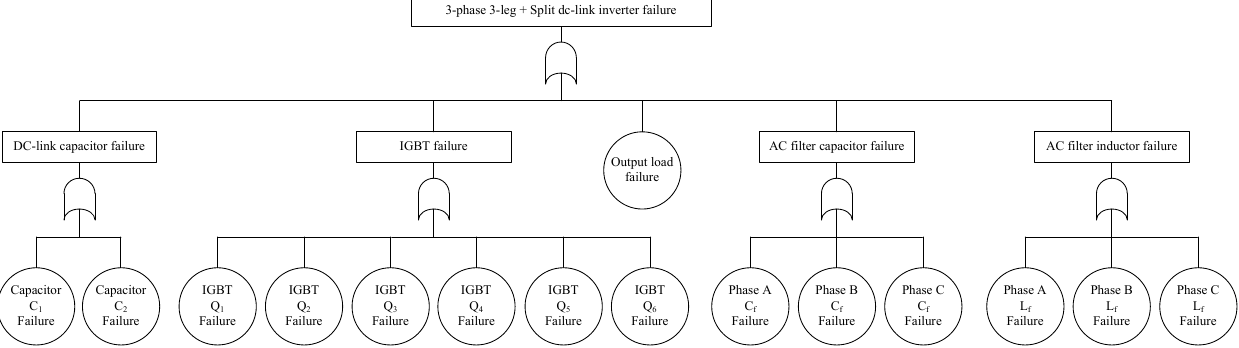
Figure 6. Failure dependency of three-phase 3-leg inverter with split DC-link capacitors.